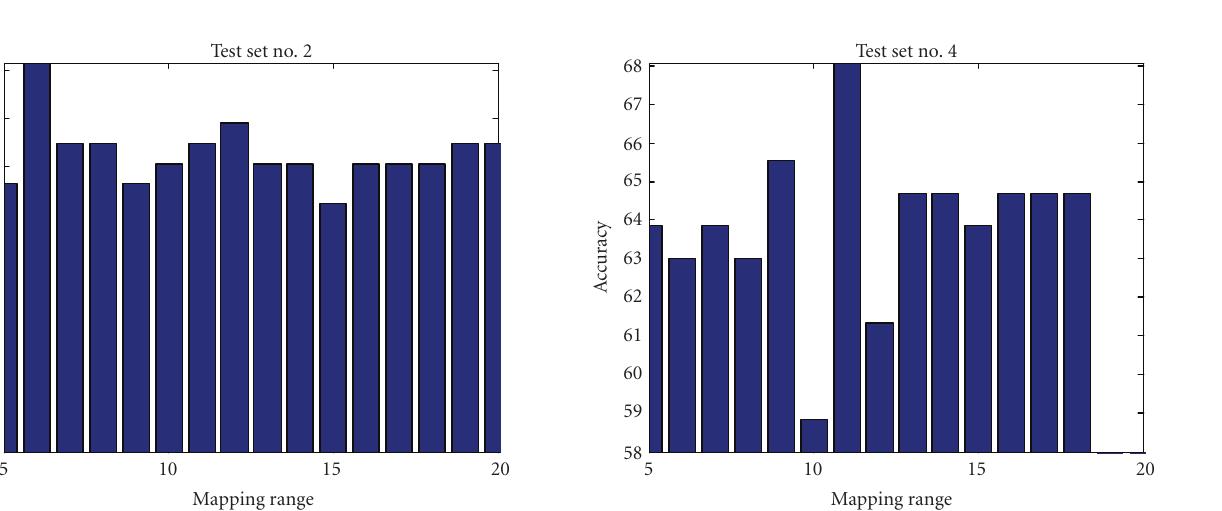
Figure 12: Mapping range impact on algorithm accuracy for test set no. 4.